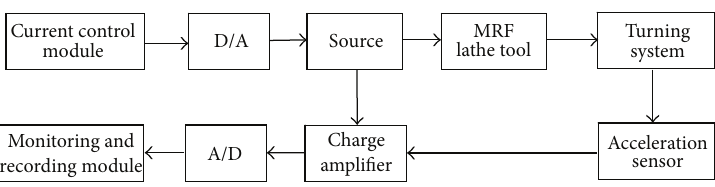
Figure 7: The system block diagram of turning damping experiment.